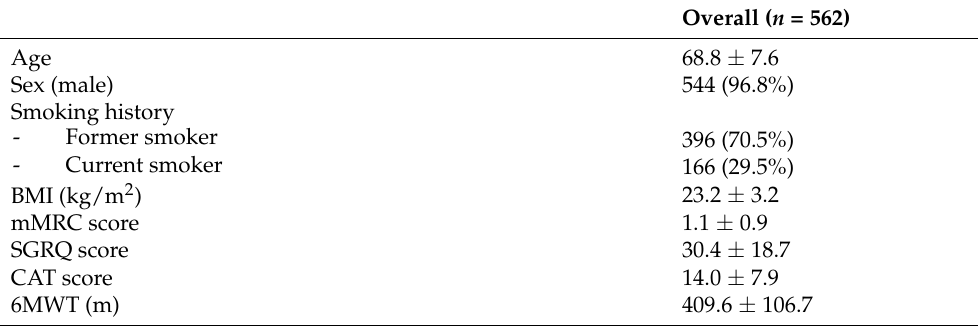
Table 1. Baseline